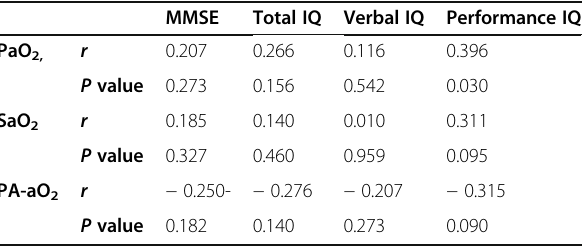
Table 4 Correlation of oxygenation parameters, with MMSE and WAIS (total IQ, verbal IQ, and performance IQ) * MMSE Total IQ Verbal IQ Performance